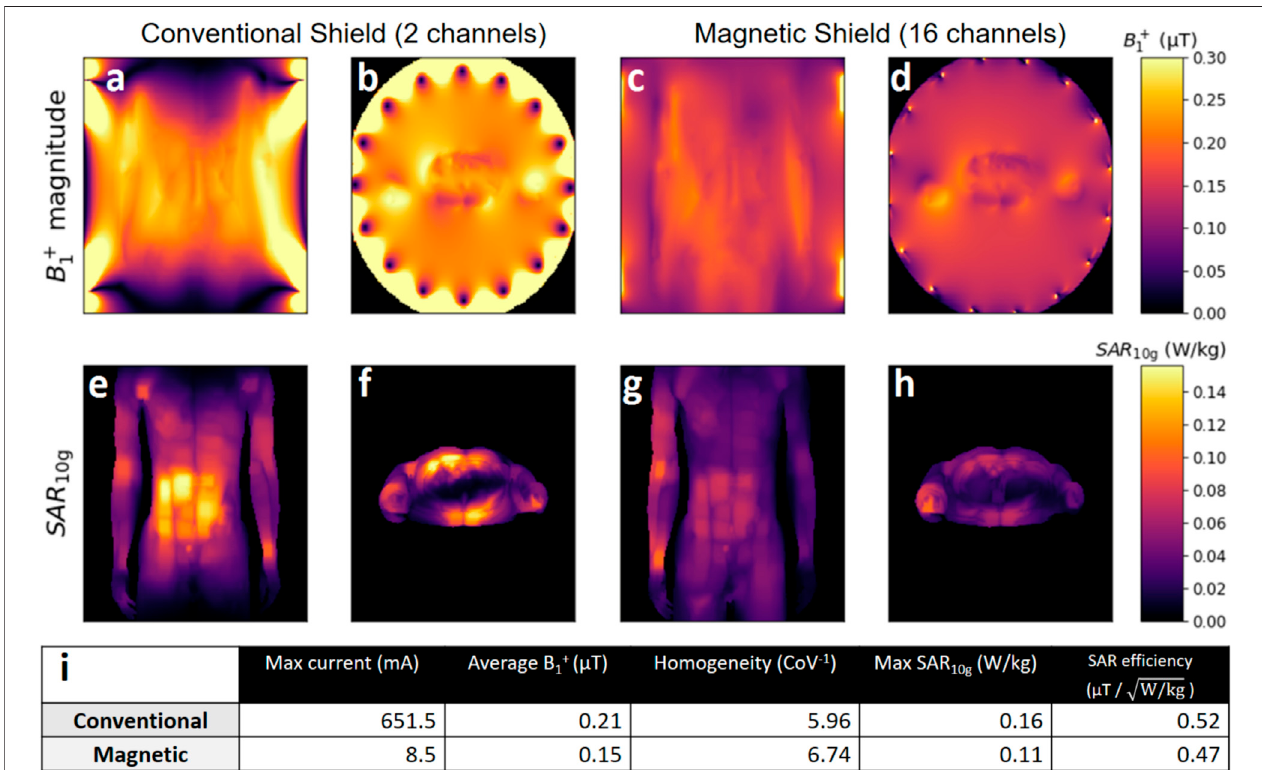
FIGURE 12 | Field distribution in the birdcage coils with conventional [PEC, (A,B,E,F) ] and magnetic [PMC, (C,D,G,H) ] shield. The top row shows coronal (A,C) and transverse (B,D) slices of the B 1+ distribution. The bottom row shows maximum intensity projections of the 10-g averaged local SAR distributions projected to the coronal (E,G) and transverse (F,H) plane. Thetable (I) summarizesimportant metrics calculatedfrom the fi elds.Maximumcurrentvaluesarefoundin theendringsofthe PEC-birdcage but in the rungs of the PMC-birdcage. All fi elds are normalized to 1 W of accepted